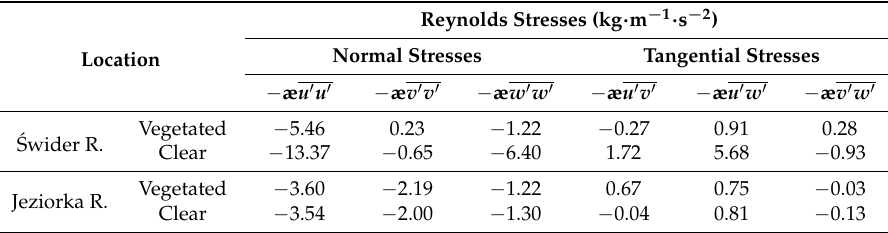
Table 4. Mean velocity, turbulence intensity, and turbulent kinetic energy of long-time measurements.